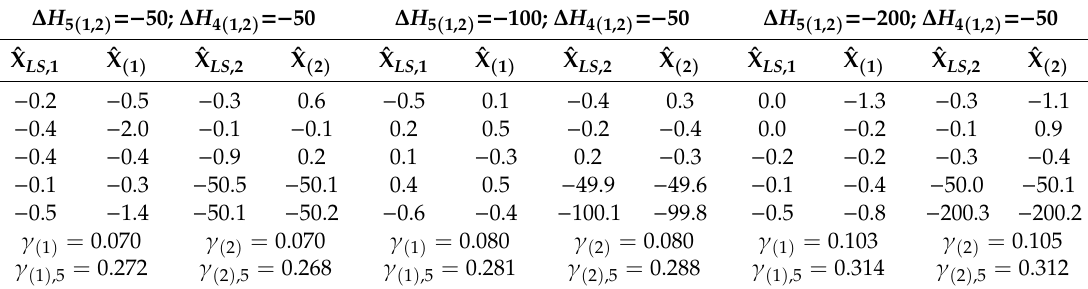
50 H    mm). 5(1,2) P and P . 5 4